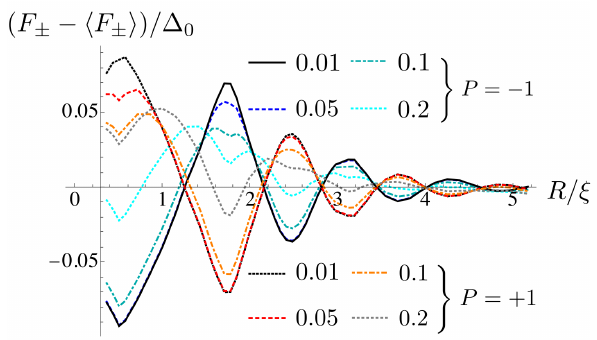
Figure 7: Same as Fig. 3 with one vortex replaced by a